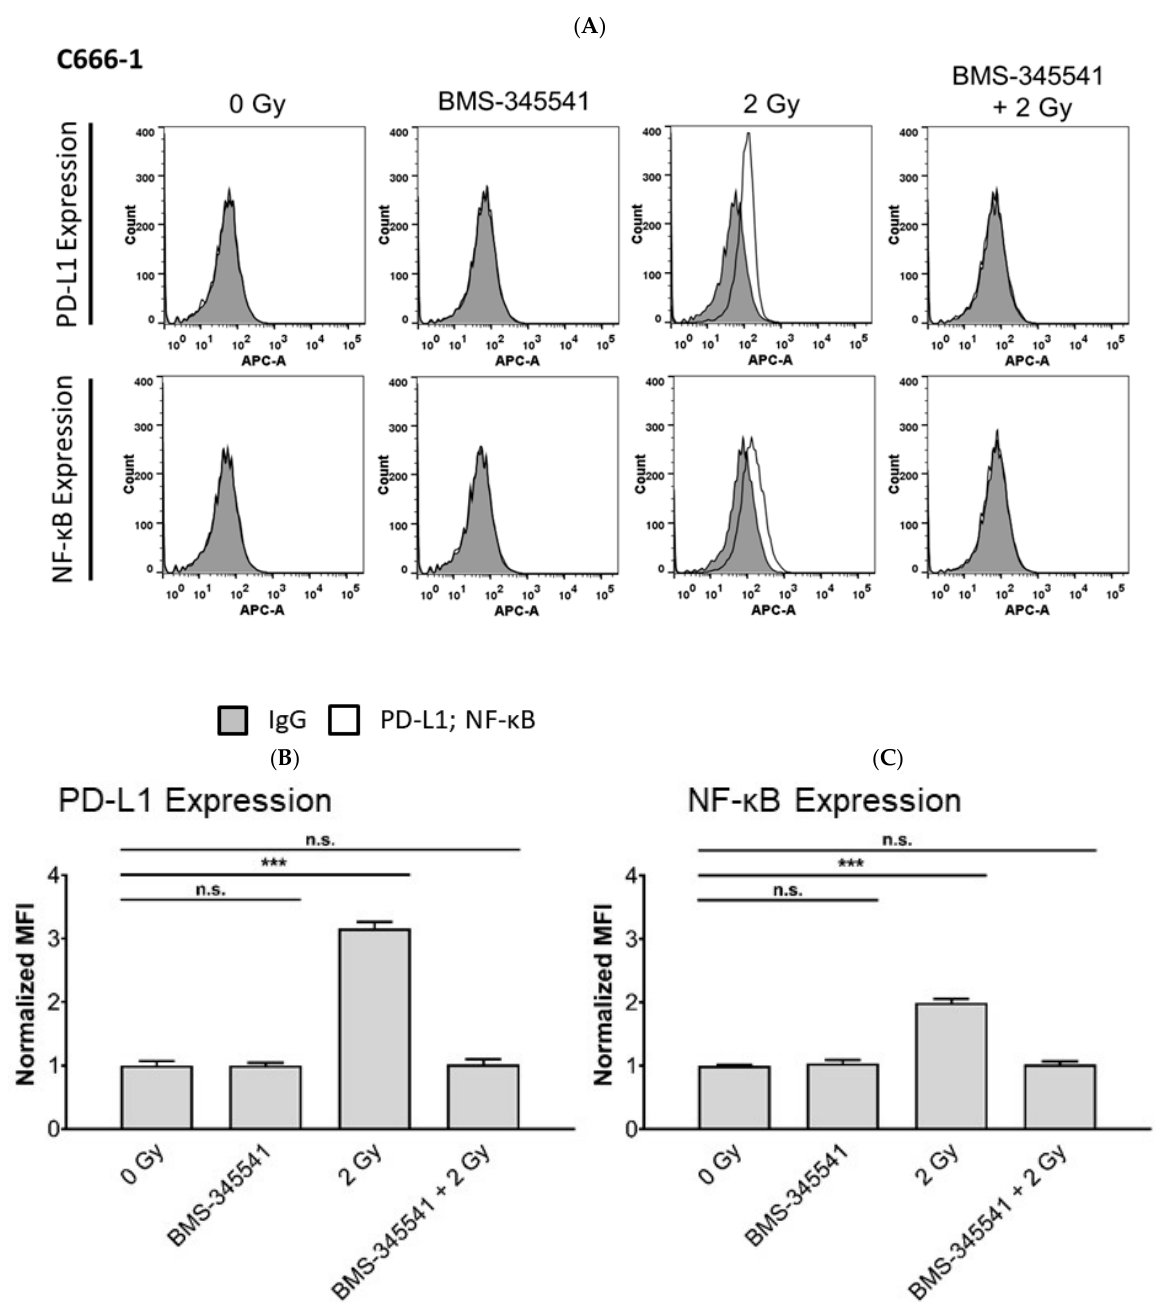
Figure 7. Radiotherapy induces PD-L1 expression in NPC cells via upregulation of NF- κ B. C666-1 cells were incubated with the NF- κ B inhibitor BMS-345541 for 1 h before radiation. Expression of NF- κ B, PD-L1 was analyzed by flow cytometry. ( A ) Histogram plots of PD-L1 and NF- κ B expression on NPC cells; quantification of PD-1 ( B ) and NF- κ B ( C ) expression on NPC cells. Quantitative data of three independent experiments are shown as normalized mean fluorescence intensity (MFI). Normalized MFI is calculated by dividing the MFI of the stained sample by the MFI of the control antibody. Data is shown as mean ± S.E.M. Asterisks indicate statistically significant differences between all cell lines (two-way ANOVA; *** p < 0.001; n.s.: not significant).